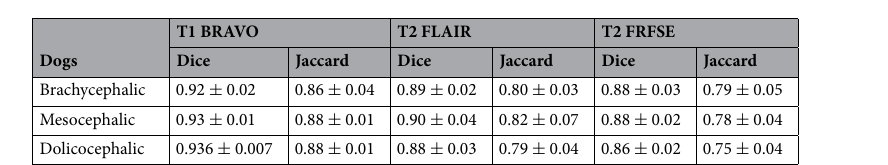
Figure 5. Cats cohort: comparison of the brain extraction results for each segmentation technique. From left to right: Original image, Manual segmentation, VIBE, BET, 3DSS and 3D-PCNN. Different sequences (T1 BRAVO, T2 FLAIR and T2 FRFSE) are shown.